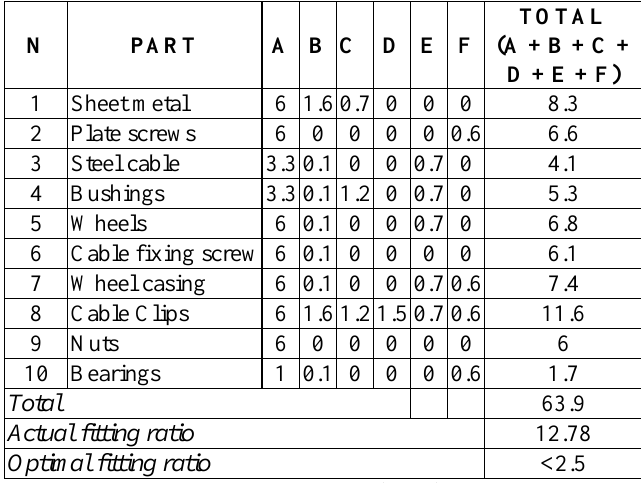
Table 1: Functional analysis of the landing gear.